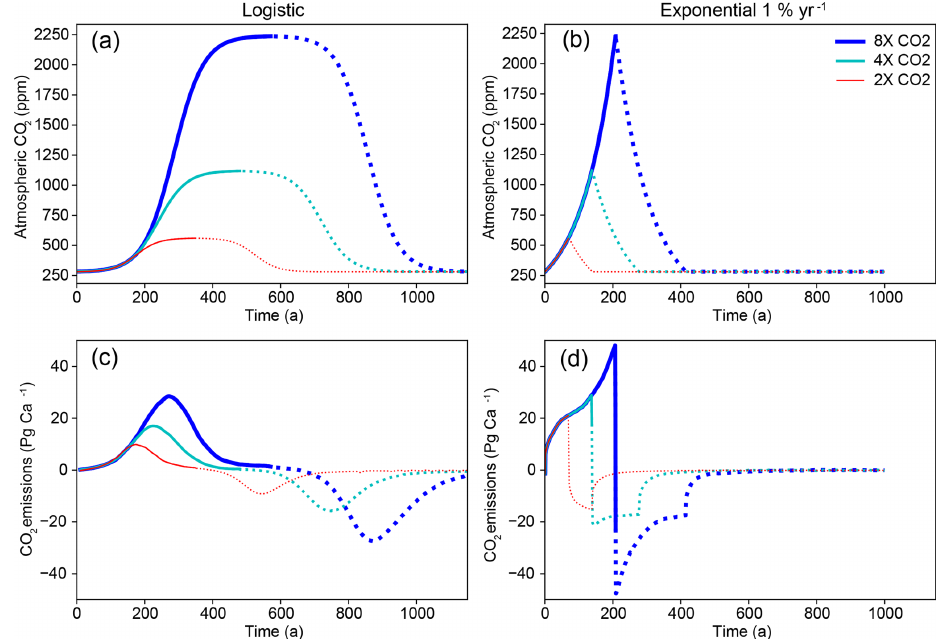
Figure 2. CO 2 pathways and diagnosed emissions for logistic and 1% experiments’ 2 × , 4 × , and 8 × CO 2 mirrored pathways. Solid lines are the increasing CO 2 phase of the simulation and dotted lines are the atmospheric CO 2 removal phase of the pathways. Note that the logistic CO 2 pathways extend over a much longer period of time than the 1% experiments. Also note that the diagnosed emissions are smooth under the mirrored logistic pathway, while emissions undergo a sharp discontinuity under the 1%-up, 1%-down experiment.